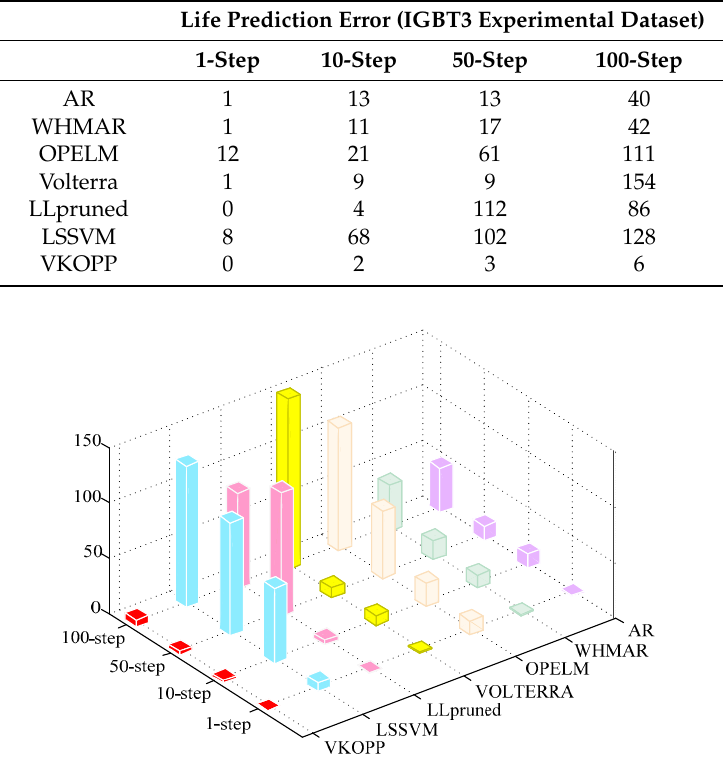
Table 8. The life prediction error result for different methodologies. Life Prediction Error (IGBT3 Experimental Dataset)